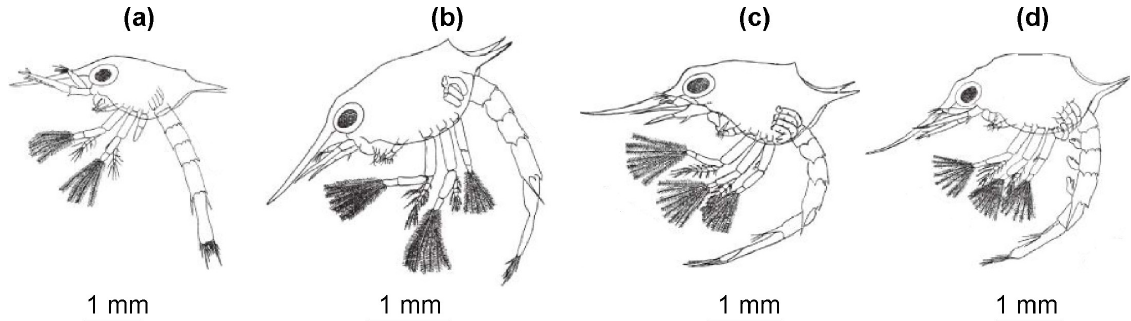
Figure 2. Common larval stages of red king crab: ( a ) zoea I, ( b ) zoea II, ( c ) zoea III, ( d ) zoea IV. Adapted from [72,75].